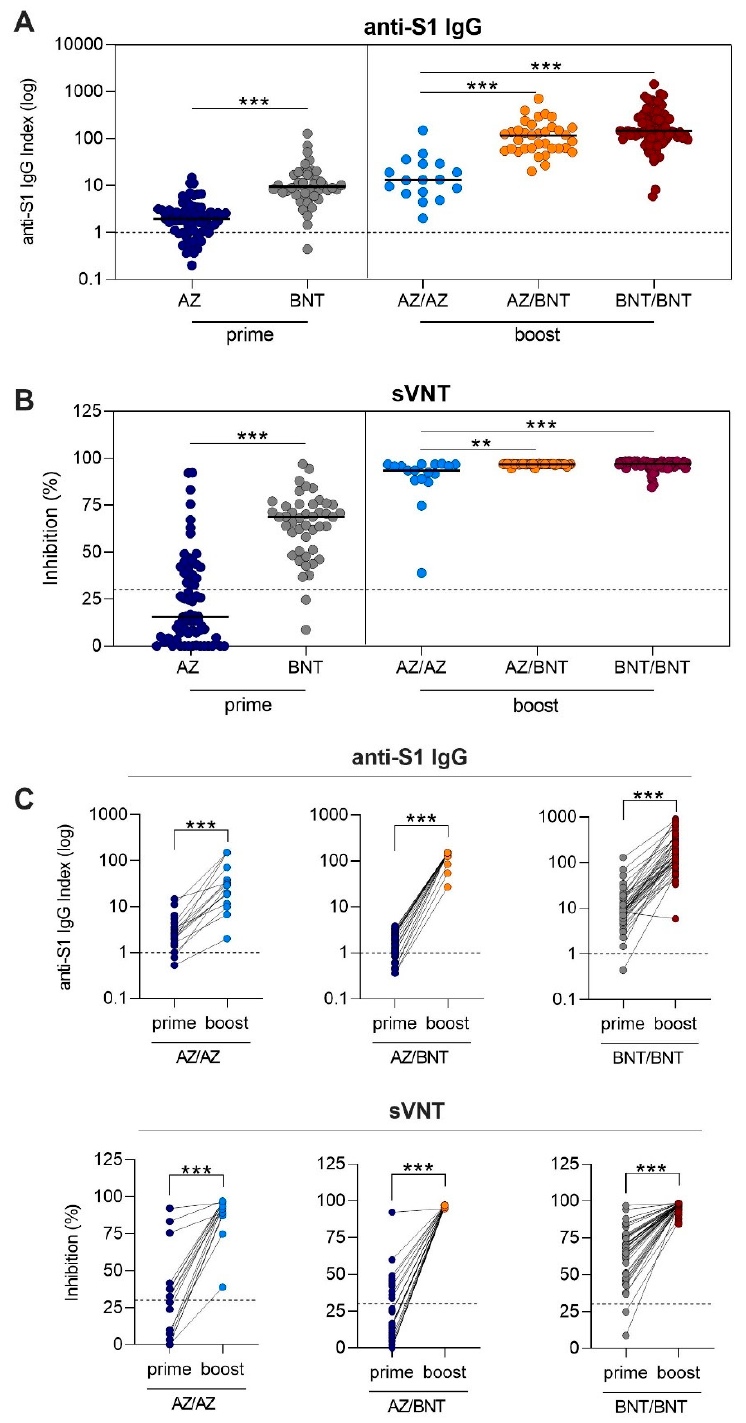
Figure 2. Anti-S1 IgG and neutralizing antibody response in health care workers after different SARS- CoV-2 prime-boost vaccination regimens. SARS-CoV-2 IgG antibodies represented, logarithmically, as an anti-S1 IgG index in health care workers after AZ and BNT prime vaccination and after AZ/AZ homologous, AZ/BNT heterologous, and BNT/BNT homologous boost vaccination ( A ). The dashed black line represents the cutoff for detection. A semi-quantitative index of <1 was classified as negative. Neutralizing antibody capacity measured by a surrogate virus neutralization test after AZ and BNT prime vaccination and after AZ/AZ homologous, AZ/BNT heterologous, and BNT/BNT homologous boost vaccination ( B ). The dashed black line represents the cut off for viral